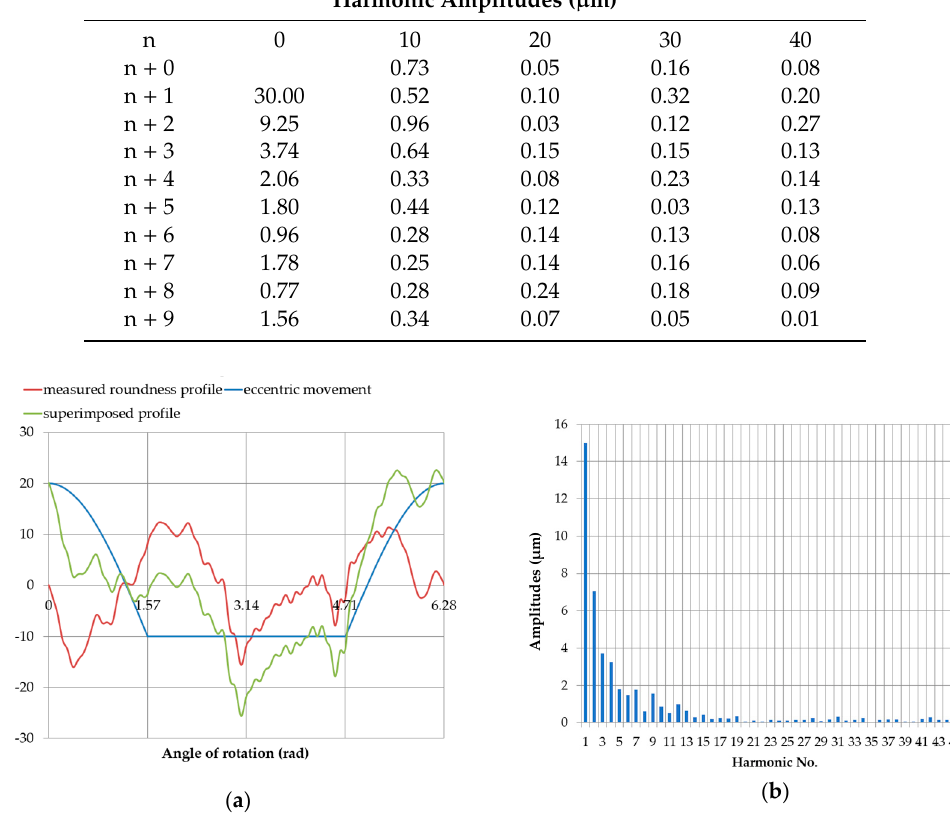
Figure 21. Profile obtained by superimposing the measured roundness profile of journal no. 5 on the eccentric movement profile of the center of the measured roundness profile with the supports set at the same height ( 𝑥 = 0 𝑚𝑚 ), with an eccentricity of the main journal e = 0.03 mm ( a ); discrete amplitude spectrum of the superimposed profile ( b ). Table 8. Amplitudes of harmonic components for the profile obtained by superimposing the measured roundness profile of journal no. 5 on the profile of the eccentric movement of the center of the measured roundness profile when the supports are set at the same height ( 𝑥 = 0 𝑚𝑚 ); with an eccentricity of the main journal 𝑒 = 0.03 𝑚𝑚 .